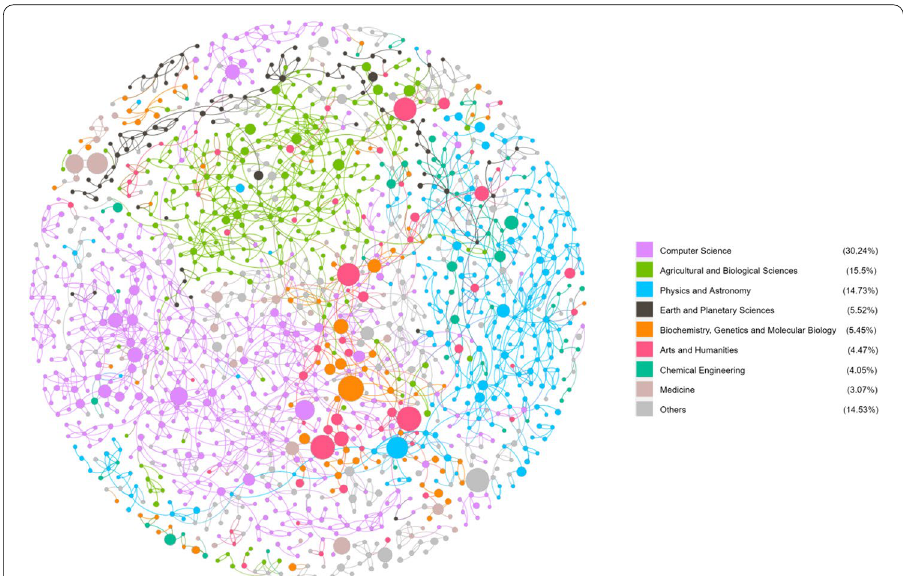
Fig. 2 A sampled subgraph of the MACN. The color of a node indicates the author’s field of interest and its size is proportional to the author’s citation